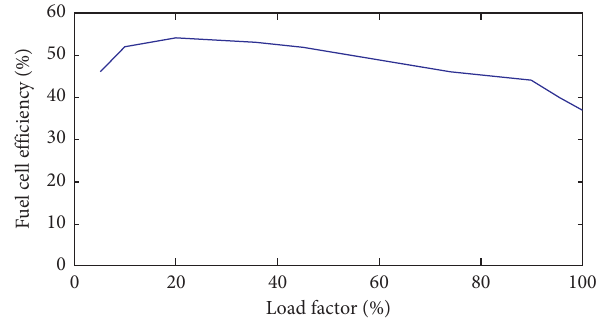
Figure 4: PEMFC efficiency